Question: Sum up the contents of this chart in one sentence.
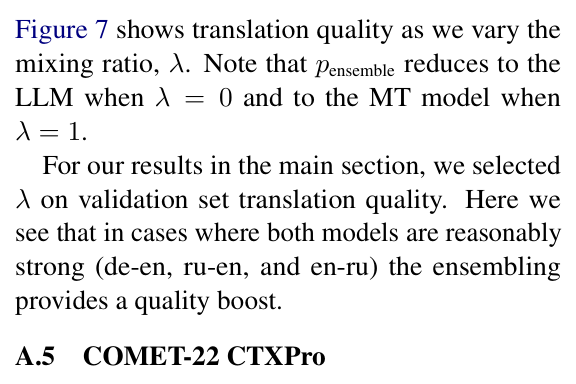
Answer: shows the COMET-22 scores correspond- ing to the document translation accuracy show in Table 5. The ensemble is always best on this data, then the MT, and then the LLM.